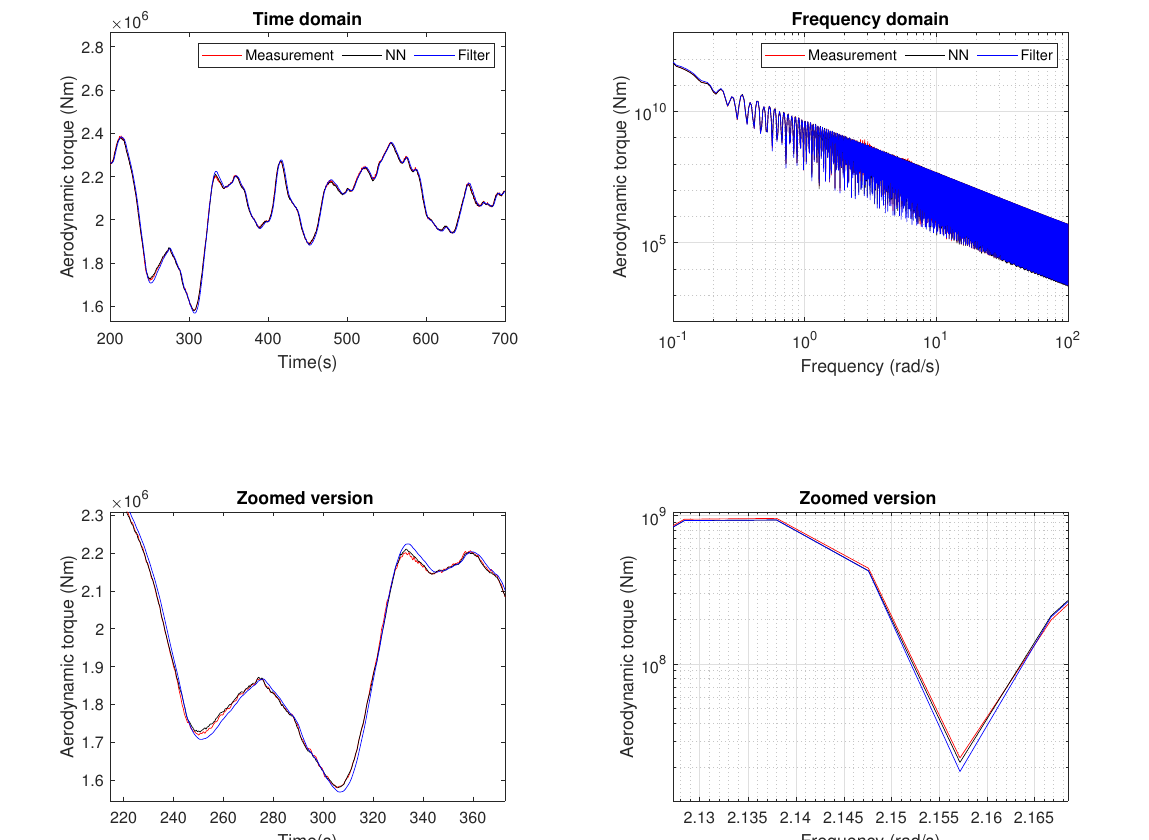
Figure 11. Scenario 3: Aerodynamic torque estimation from Turbine 5. In Scenario 1, for both turbines, the time domain results demonstrate that the aero- dynamic torque estimated by the NN-based estimator tracks the measurements more closely than that estimated by the conventional aerodynamic torque estimator; however, the improvement shown by the corresponding power spectra is not as